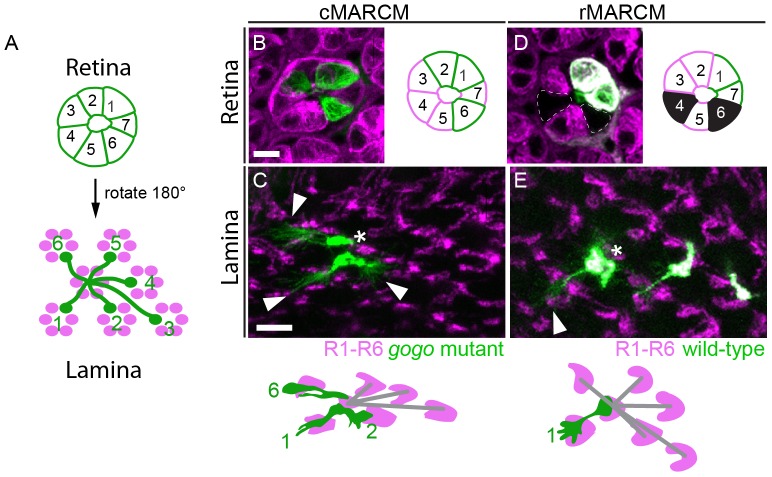
Absence of Gogo in single R cells does not influence cartridge selection.(A) Schematic of cartridge target selection. R1–R6 projection pattern is specific and uniform for each R1–R6 fascicle. Axon extensions occur in the control 180° rotated with respect to the position of their cell bodies. (B–E) Single cells were made homozygous for gogo null allele via mitotic recombination. Asterisks mark start and arrowheads end of axon extensions. (B, C) In the complementary MARCM (cMARCM) approach mutant R axons are labeled by mCD8-GFP (green) and wild-type cells are labeled with Gmr-KO (magenta). gogo mutant R axons surrounded by wild-type cells choose correct targets in the lamina (C) with respect to the position of their ommatidial cell bodies (B). (D, E) In the reverse MARCM approach (rMARCM) single wild-type axons are labeled with mCD8-GFP in a wild-type Gmr-KO labeled background (magenta) and unlabeled gogo mutant R cells that appear in black (dashed lines). Wild-type axons adjacent to mutant axons target correctly (E) with respect to their cell-bodies (D). Scale bars: 5 µm.